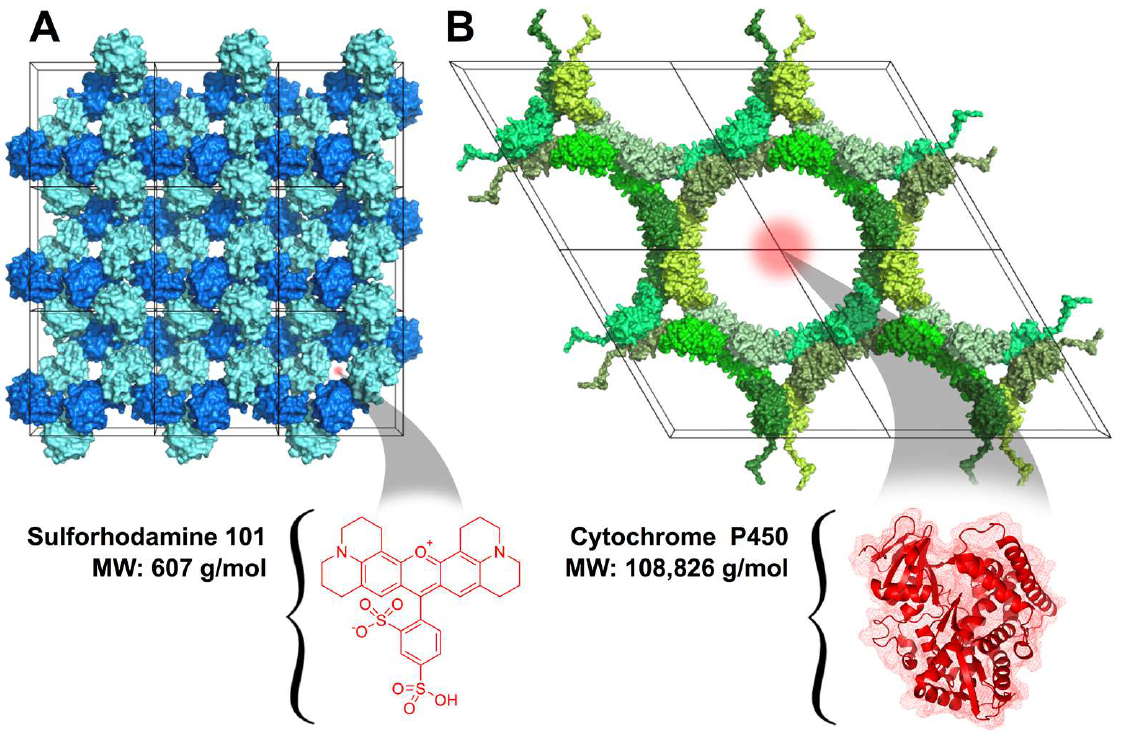
Figure 1. ( A ) Cross-linked tetragonal HEWL crystal lattice (PDB: 2HTX) showing small archetypal protein crystal pore sizes (<2 nm) that can accommodate small molecules such as sulforhodamine 101. ( B ) CJ-LPC crystal lattice (PDB: 5W17) shows much larger (13 nm diameter) pores that can accommodate macromolecular guests such as the cytochrome P450 heme domain (PDB: 2HPD).